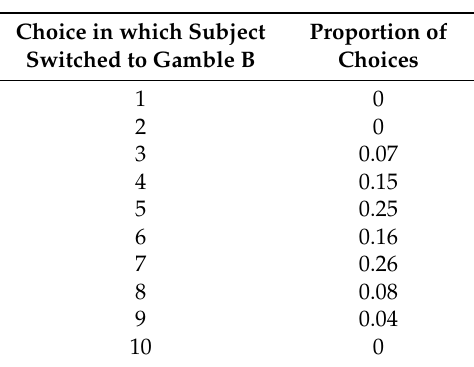
Table A2. Choice in the Gambles.